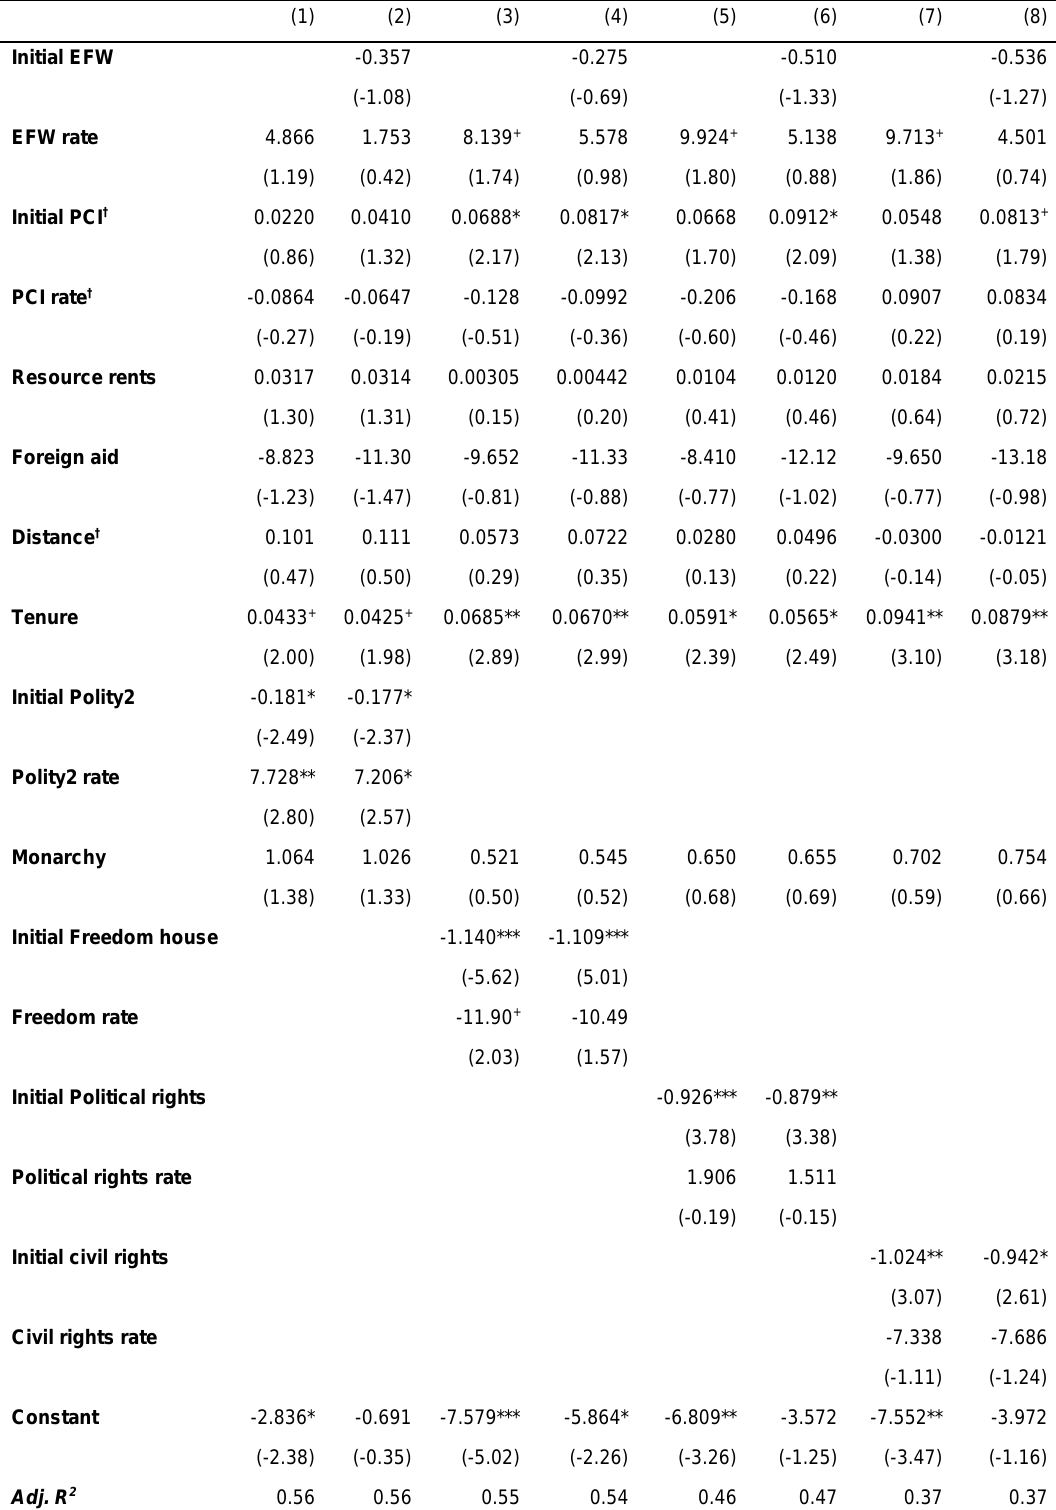
Table 2. Effect of Economic and Political Institutions on the Wealth of